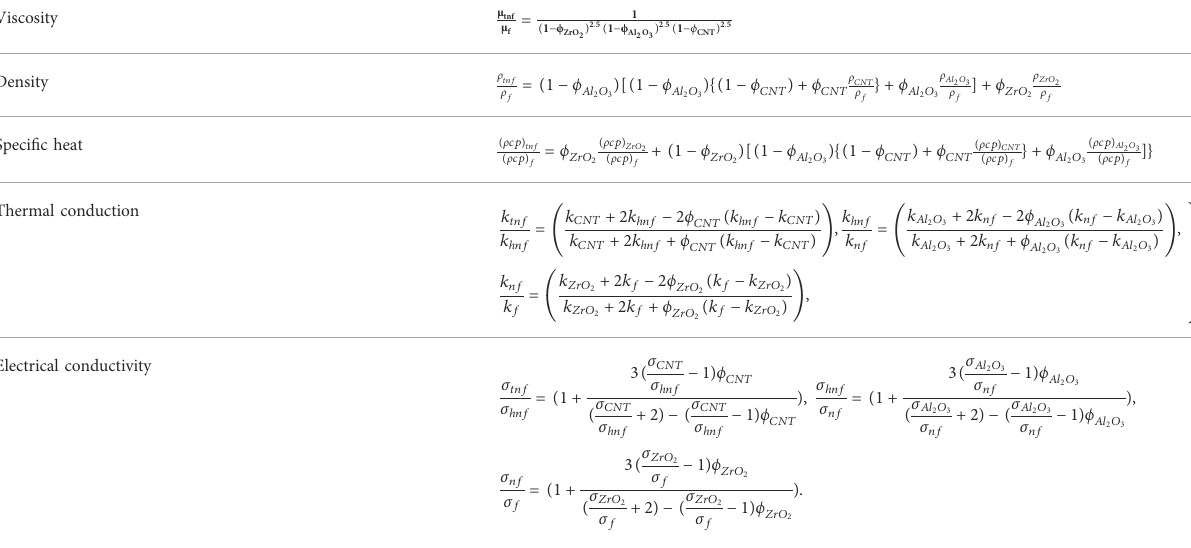
TABLE 2 Thermochemical properties of ternary hybrid nano fl uids Alharbi et al. (2022), Bilal et al. (2022b). Viscosity